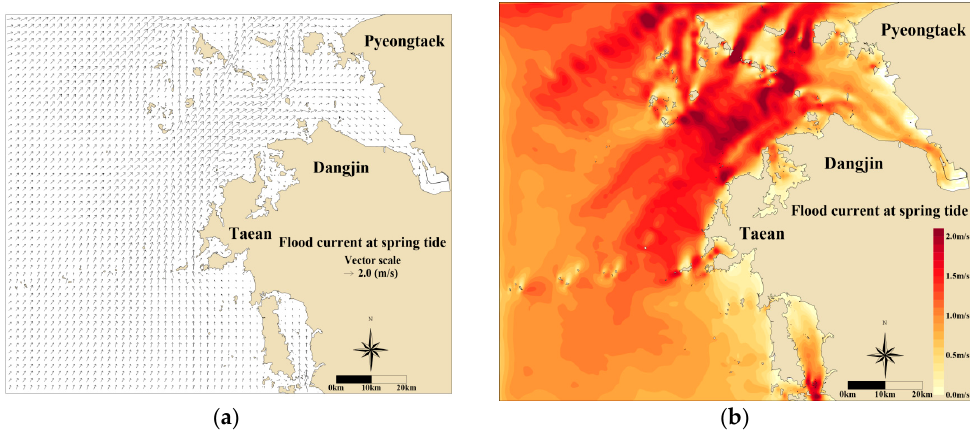
Figure 11. Ebb current at spring tide in the surface layer: ( a ) temporal current velocity vector and ( b ) contour plot.